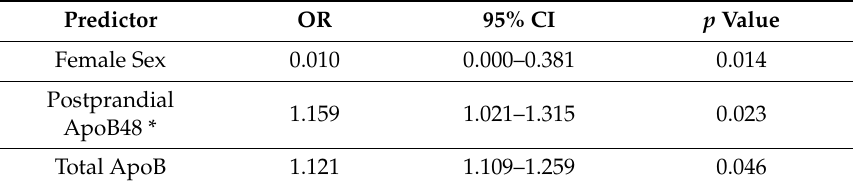
Table 5. Logistic regression of characteristics associated with pathologic cIMT (p > 90) in patients with rheumatoid